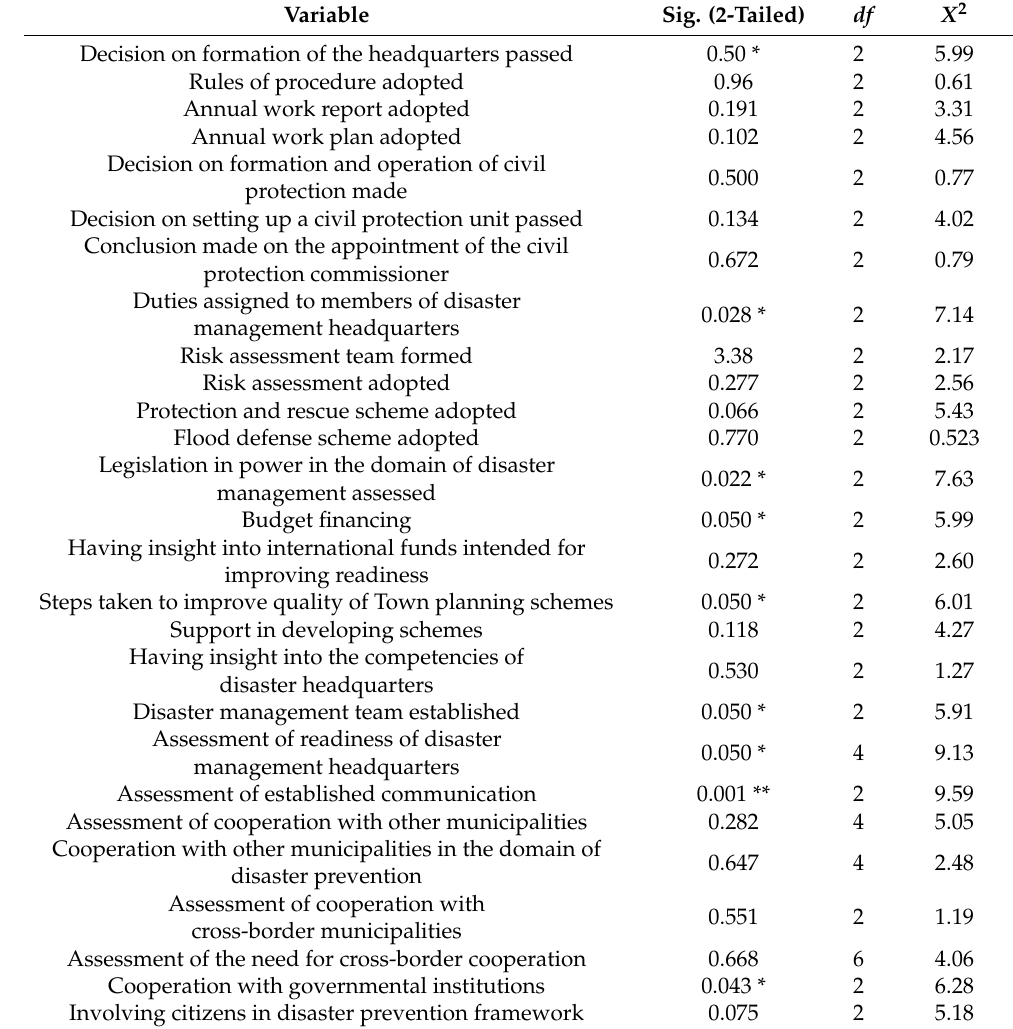
Table 6. Chi-square test results relating to disaster management units on the degree of awareness of local self-government